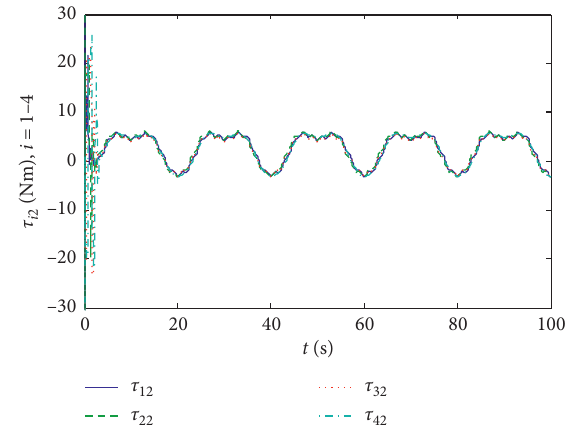
Figure 8: The control input torque τ